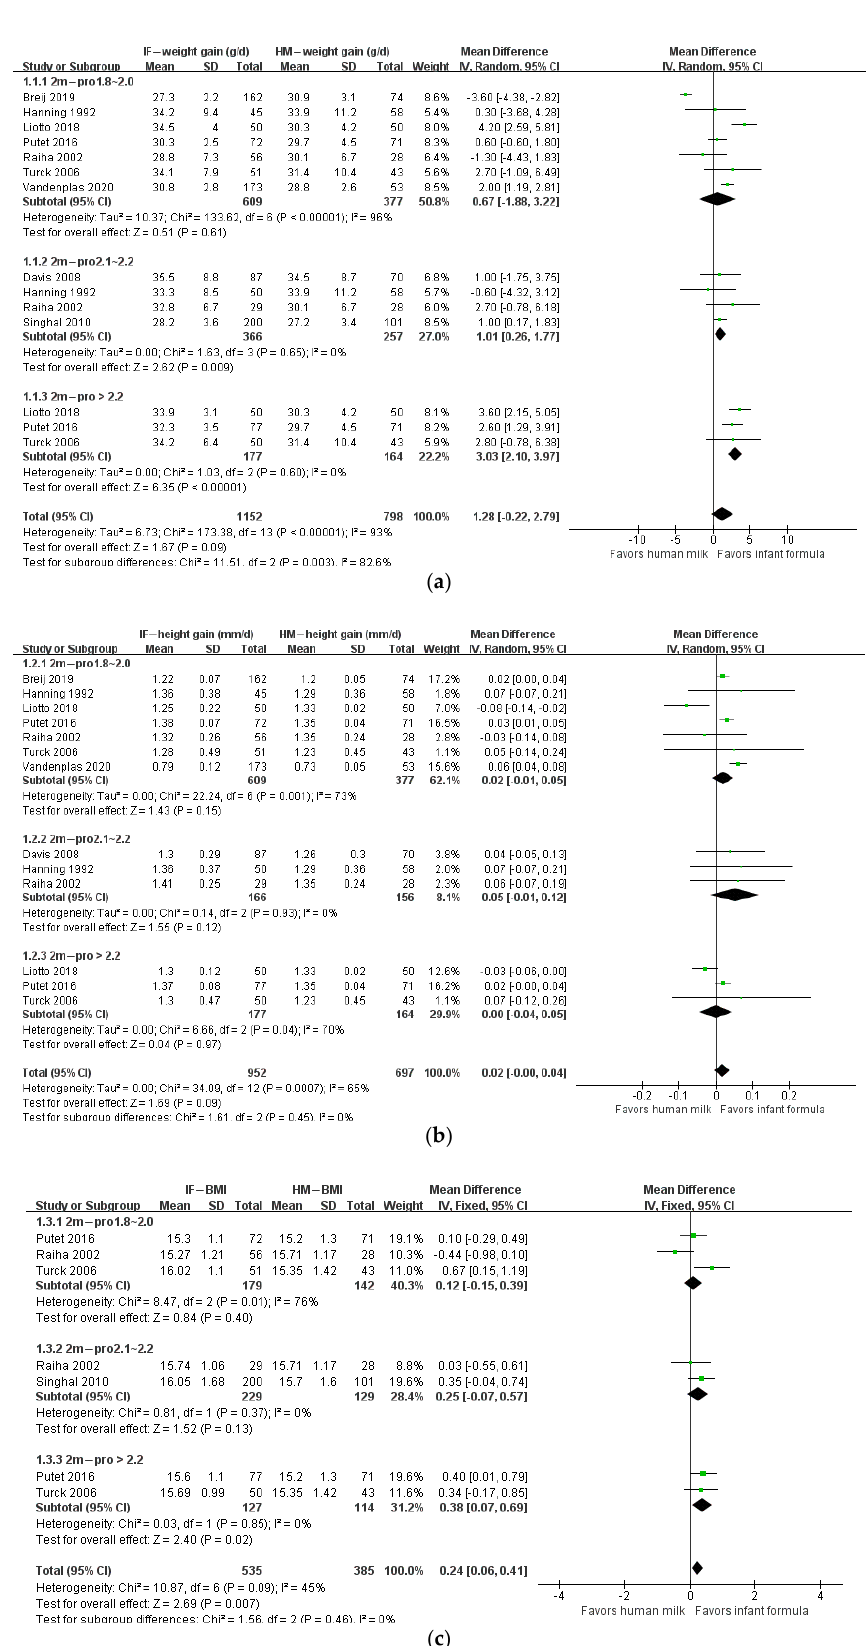
Figure 3. Forest plot of the effects of protein content of infant formula on the weight gain, height gain, and BMI of infants at 2 months of age. ( a ) The effects on weight gain. ( b ) The effects on height gain. ( c ) The effects on